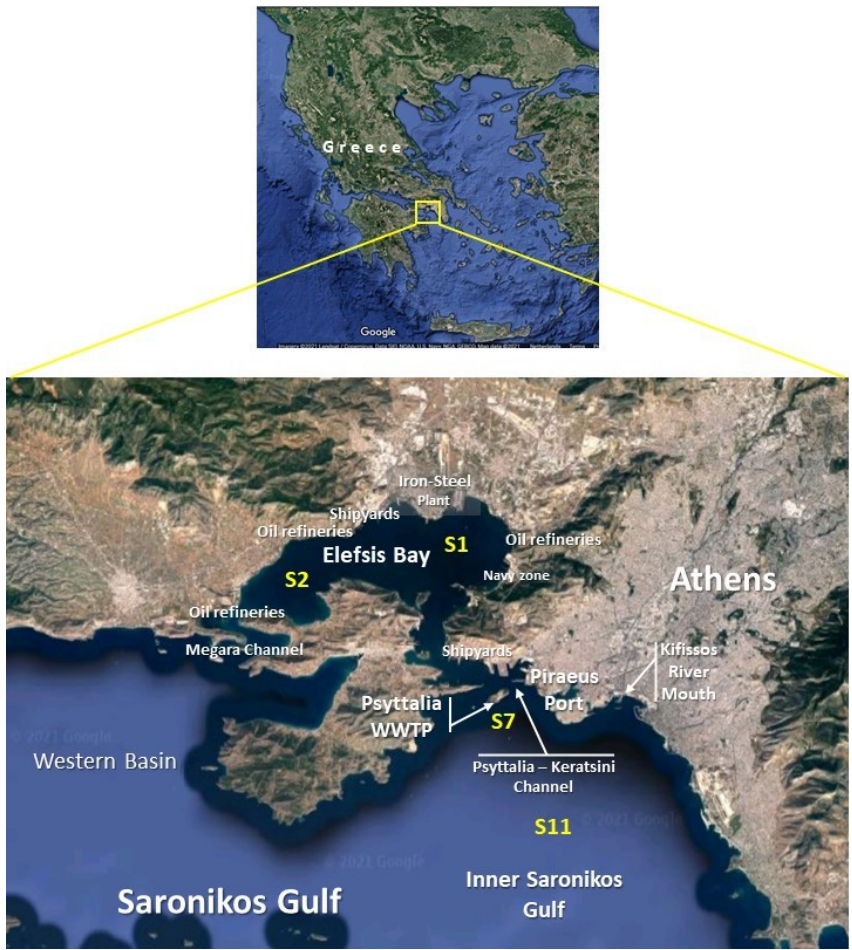
Figure 1. Sampling stations in the Inner Saronikos Gulf and Elefsis Bay.